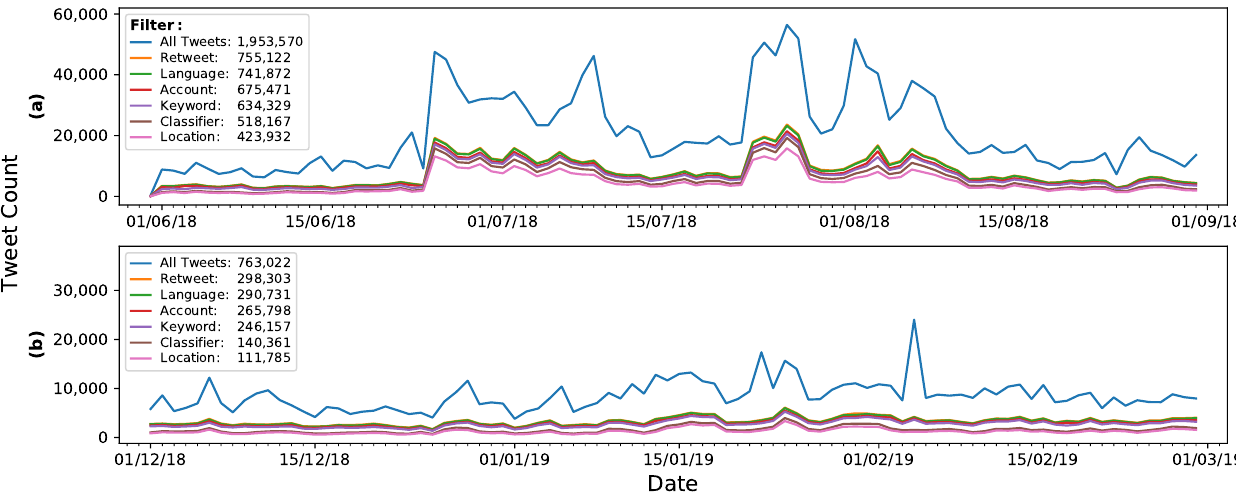
Figure 1. Change in tweet count at different stages of filtering for Dataset 1 ( a ) and Dataset 2 ( b ). Filter 1: Retweets and